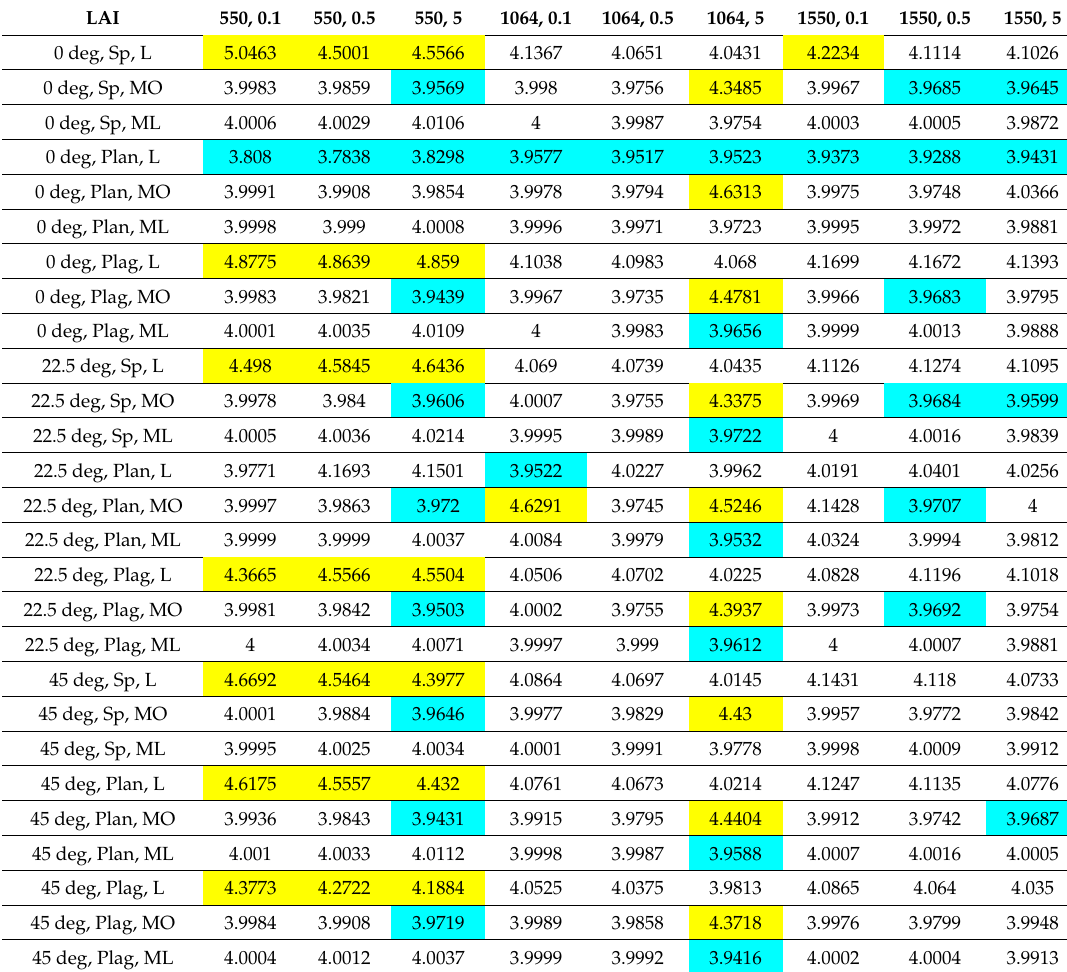
Table A3. LAI statistic for each configuration. The shorthand for the descriptions for the columns are wavelength in nm and footprint in m, while the rows are zenith view angle in degrees, LAD type (Sp–spherical, Plan–planophile, Plag–plagiophile), and leaf BSDF (L–Lambertian, MO–model reflectance non-transmitting, ML–model reflectance Lambertian transmittance). Yellow highlights are the top 10% while the blue highlights are the bottom 10% of the data points. LAI 550,